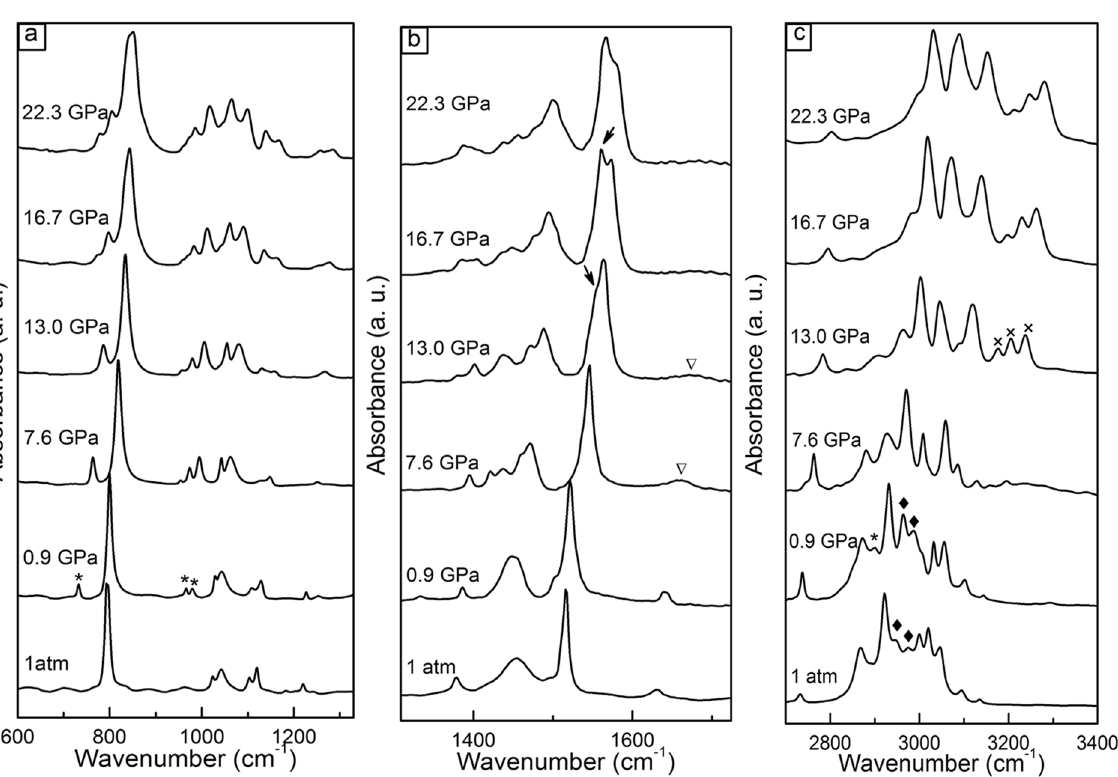
Figure 9. Evolution of the IR spectra of p -xylene measured under high pressure and room temperature: ( a ) Evolution of the skeletal and CH 3 stretching region; ( b ) Evolution of the CH 3 deformation and C = C stretching region; and ( c ) Evolution of the CH 3 and C–H stretching